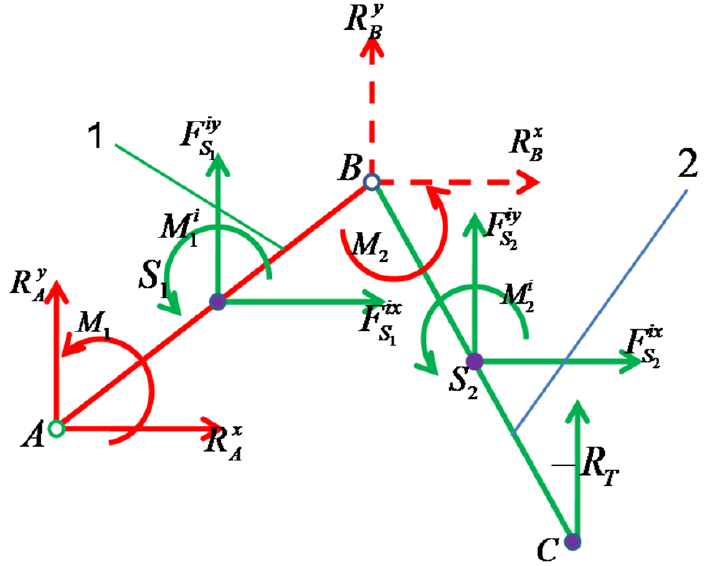
Figure 1. The articulated robot mechanism with two degrees of mobility.